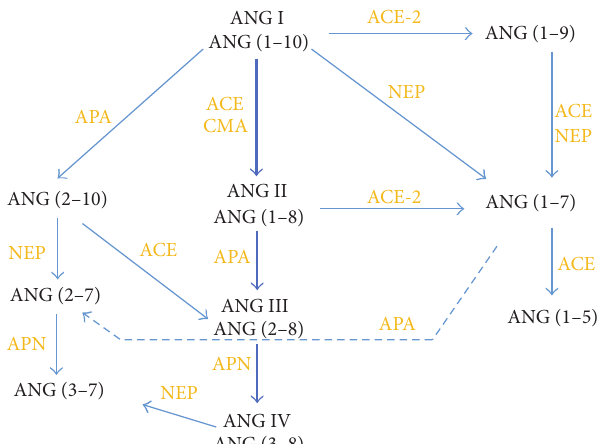
Figure 1: Main pathways of ANG I metabolism. ACE: angiotensin converting enzyme; ACE-2: angiotensin converting enzyme type 2; APA: aminopeptidase A; APN: aminopeptidase N; CMA: chymase; NEP: neutral